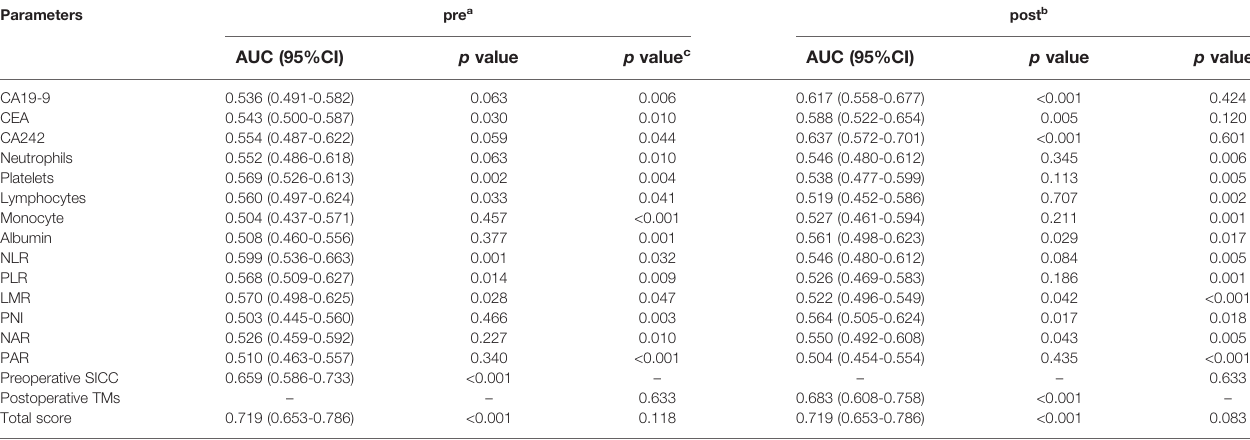
a Indicates preoperative serum index. b Indicates postoperative serum index.